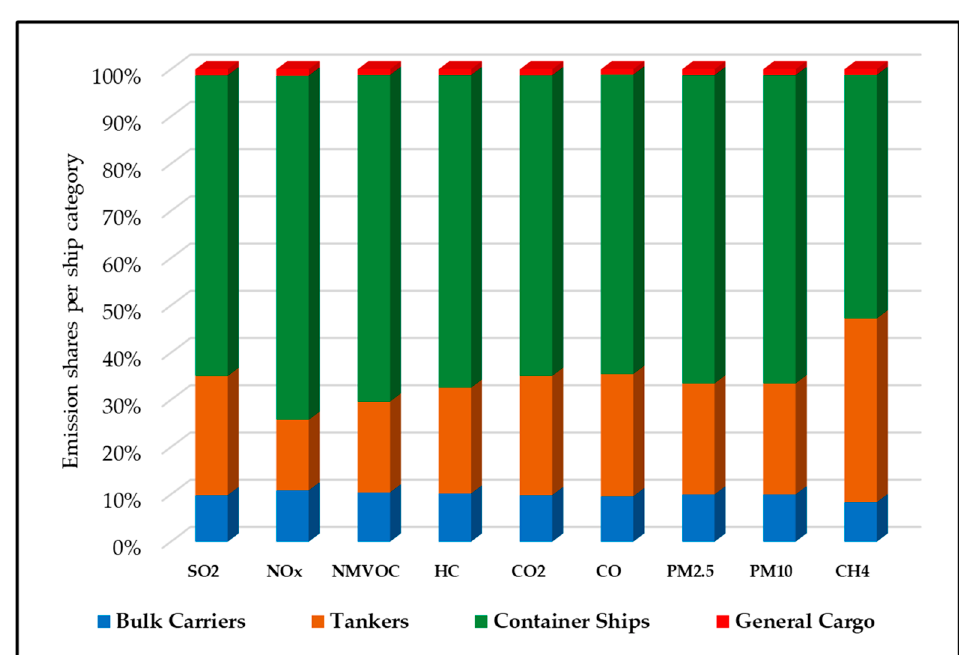
Figure 3. Ship emissions of various ship types at MBQP in 2020.